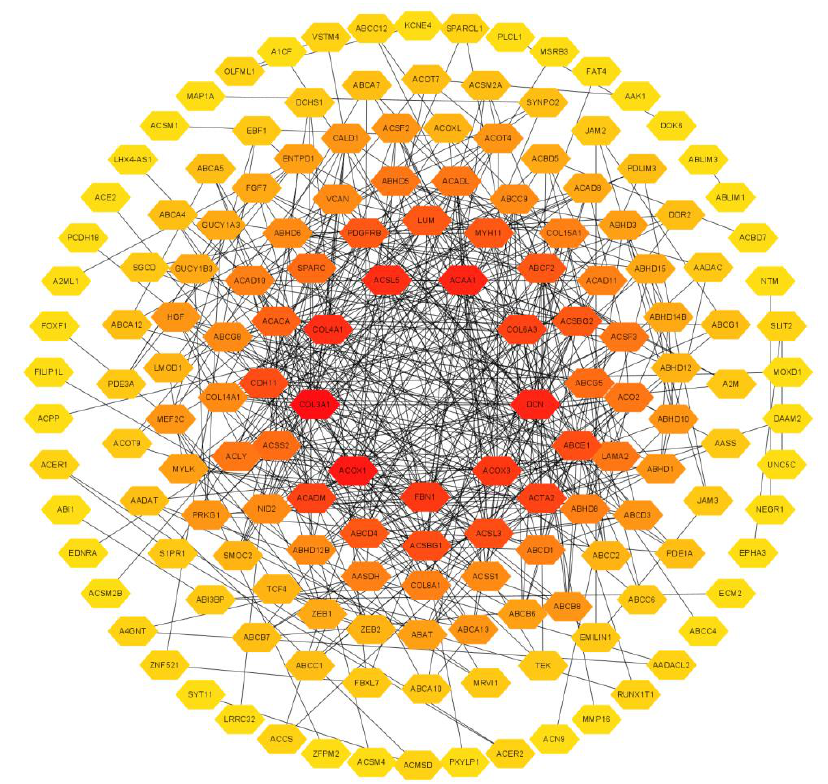
Figure 8. PPI network for EPHA3 and co-expressed genes. The network was composed of 159 nodes and 491 edges, which indicates that EPHA3 may interact with these proteins in BLCA.